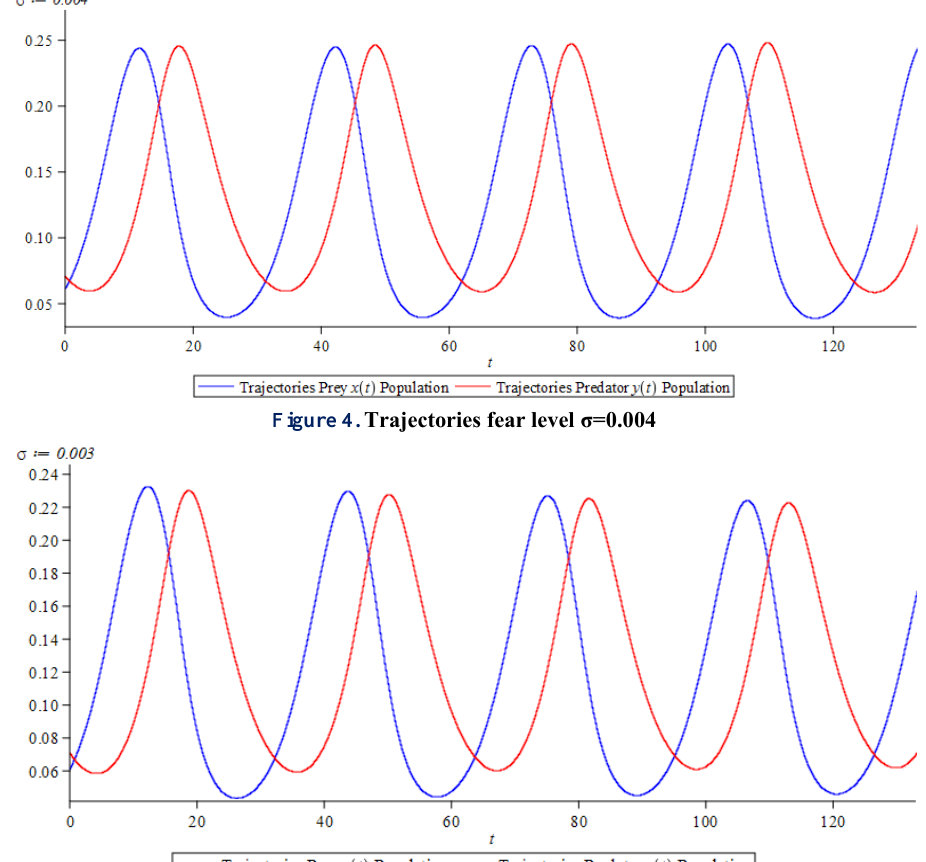
Figure 5. Trajectories fear level σ=0.003